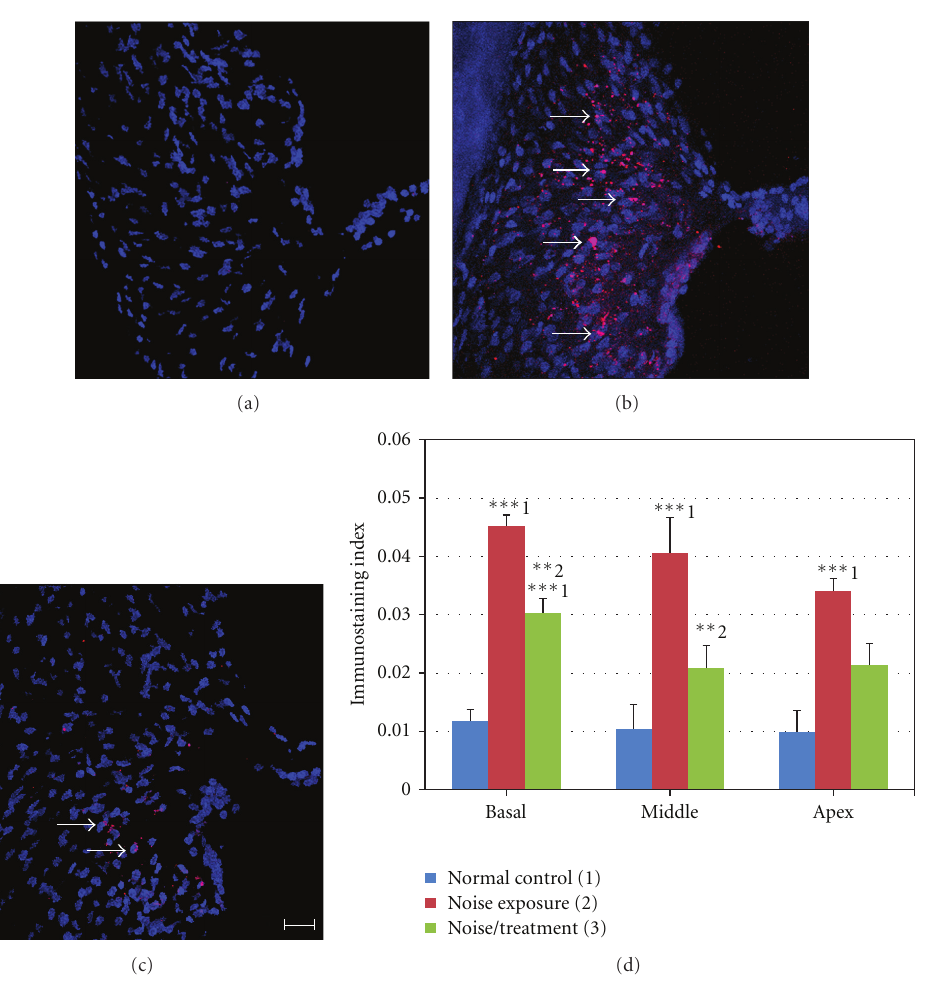
Figure 5: NT immunostaining and immunostaining index in the spiral ligament. Examples of NT immunostaining images obtained from the spiral ligament in the middle turn of cochleae in the normal control (a), the noise exposure (B), and the noise/treatment (c) groups by confocal microscopy. No significant NT immunostaining was found in the spiral ligament of the normal control group (A). A large number of NT positive cells were found in the spiral ligament of the noise exposure group (arrows in (b)) while a significantly decreased number of NT positive cells were found in the noise/treatment group (arrows in (c)). The results of the immunostaining index are shown in (d). A high NT immunostaining index was found in the spiral ligament in all three turns of the noise exposure group. There were significant di ff erences between the normal control and the noise exposure groups in the cochlear three turns, and between the noise exposure and the noise/treatment groups in the basal and middle turns. There was no significant di ff erence between the noise exposure and the noise/treatment groups in the apical turn. The numbers (1, 2, 3) in (d) indicate the normal control, noise exposure, and noise/treatment groups, respectively ( ∗∗∗ and ∗∗ indicate P < 0 . 001 and < 0.01, resp.). Scale bar = 20 μ m in (c) for (a)–(c) (error bars represent standard error of the means. Number of cochleae = 6 in each